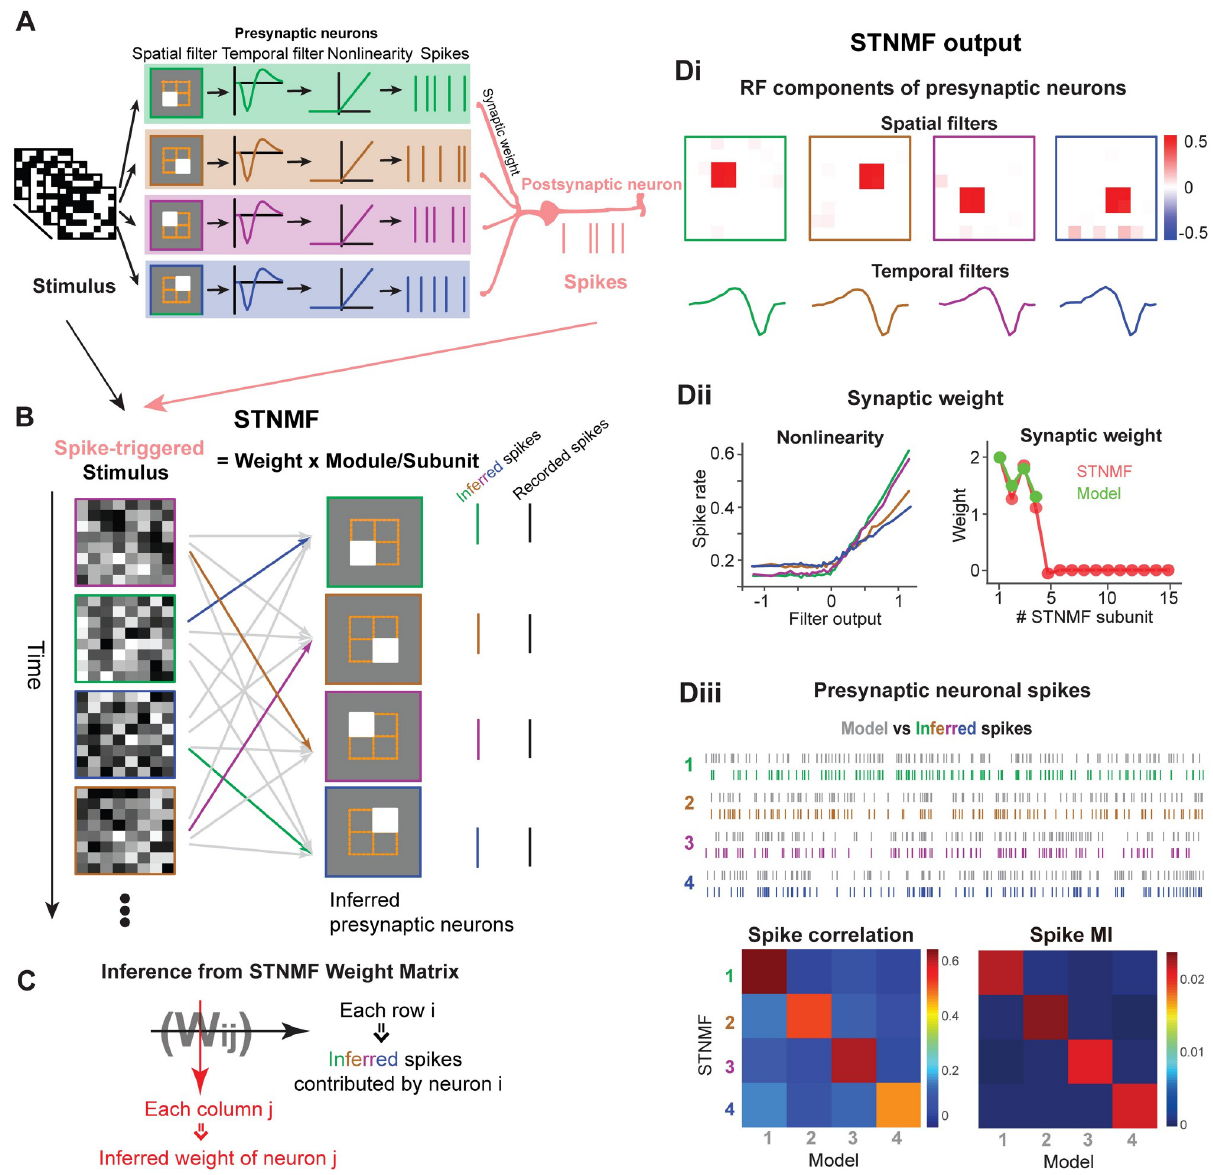
Fig 1. Workflow of STNMF. (A) Illustration of a minimal neural network model with four presynaptic RGCs and one postsynaptic LGN neuron. (B) Illustration of STNMF analysis. Averaging of the ensemble of spike-triggered stimulus images yields a single STA filter. STNMF reconstructs this ensemble by approximating it with a set of modules and a matrix of weights. One of the modules is strongly correlated to one of the spikes/images indicated by stronger (black lines) or weaker (gray lines) weights. (C) Illustration of STNMF weight analysis. Synaptic weights inferred by each column of the STNMF weight matrix, and spikes contributed by each presynaptic neuron inferred by each row of the matrix. (Di-iii) STNMF outputs. (i) Receptive field (RF) components of presynaptic neurons. Spatial filters (top) as subunit components of STNMF, and the corresponding temporal filters. (ii) Nonlinearity and synaptic weights from presynaptic neurons to the postsynaptic neuron. Ground-truth values of the model (green). The values computed from the weight matrix (red). Here weights were set as [2 1.5 1.8 1.3] for four neurons. (iii) STNMF separates the whole set of postsynaptic spikes into a subset of spikes contributed by each presynaptic neuron. Model spikes (gray) and inferred spikes (colored) of each presynaptic neuron. Correlation matrix of spike trains from model and STNMF (left). (Right) The matrix of mutual information (MI) carried by inferred spikes for each presynaptic neuron indicates that inferred spikes are similar to model